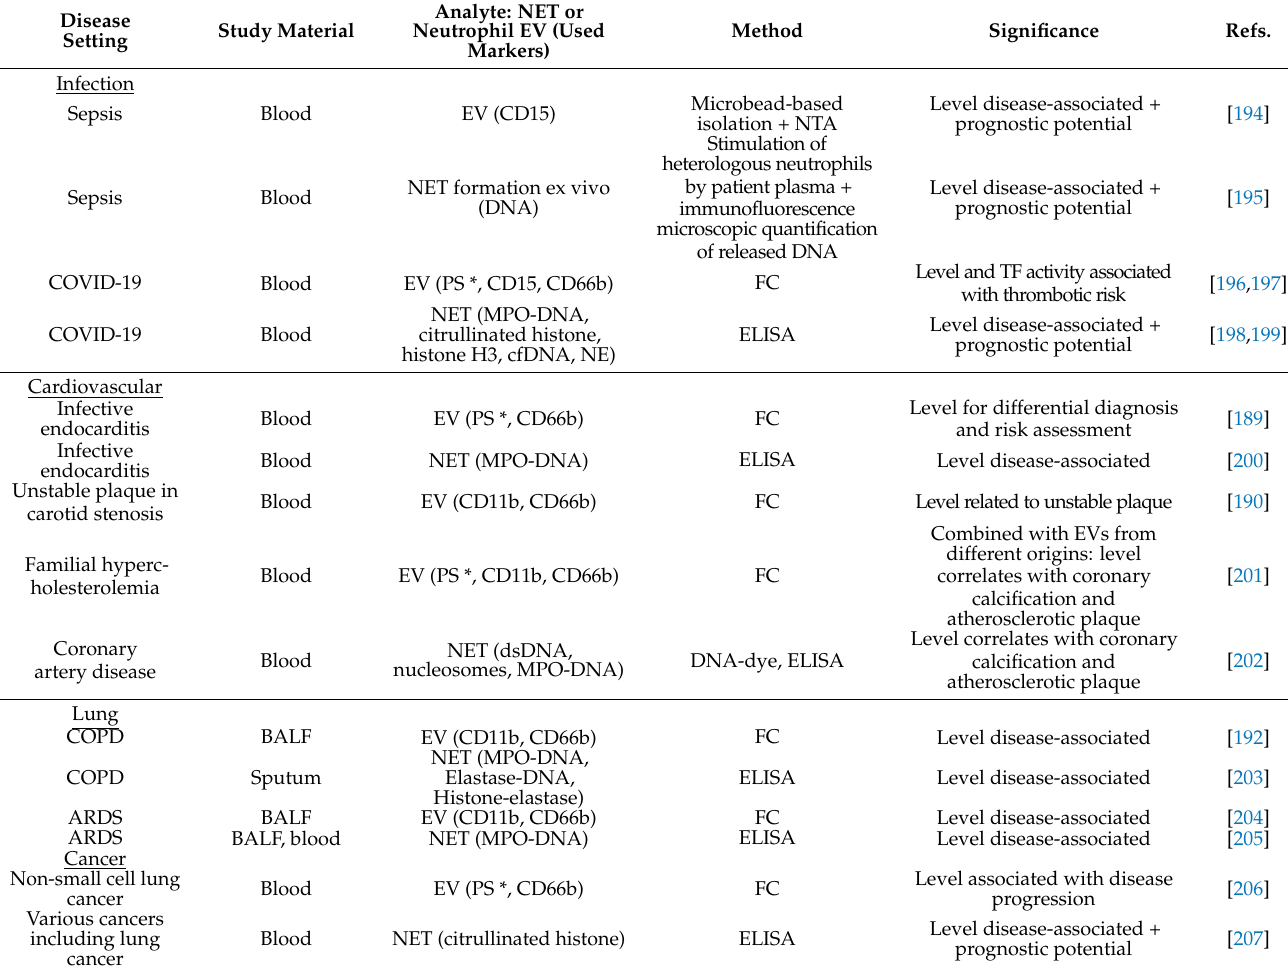
Table 3. Examples of the potential prognostic and diagnostic use of neutrophil-derived EVs and NETs. Disease